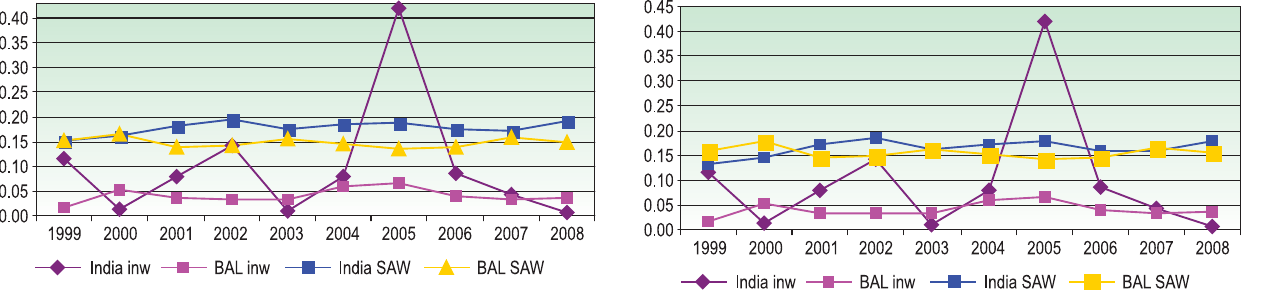
Fig. 6 . FDI growth rates vs aggregated index SAW (the fi rst assumption)